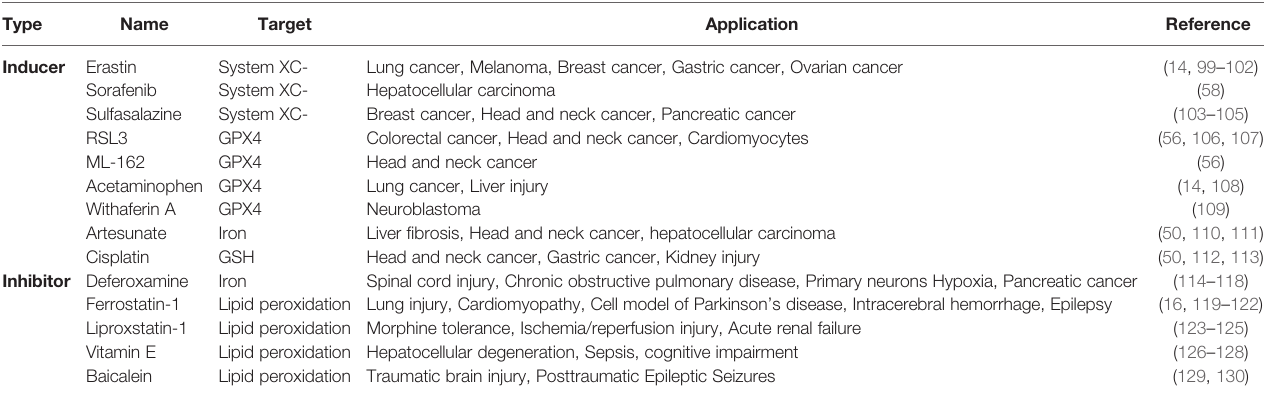
TABLE 1 | Potential mechanisms of drugs in the treatment of diseases by targeting